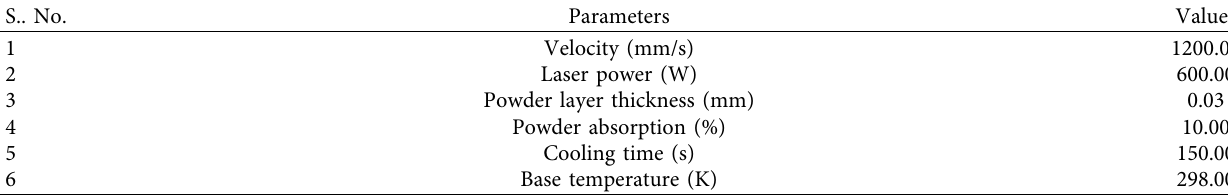
Table 6: 3D -printing